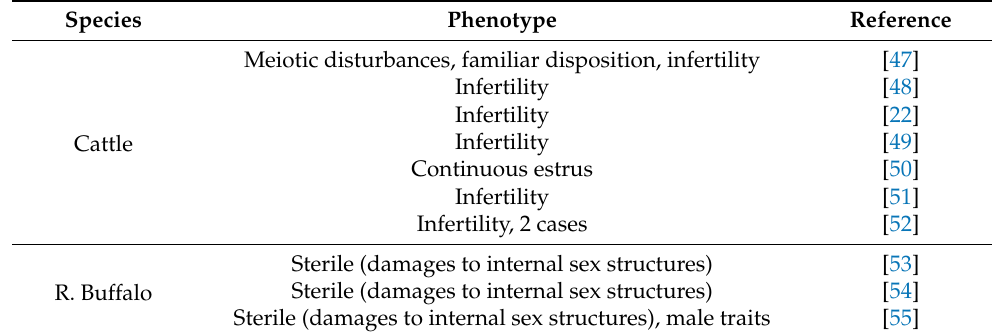
Table 3. X-trisomy in domestic bovids.